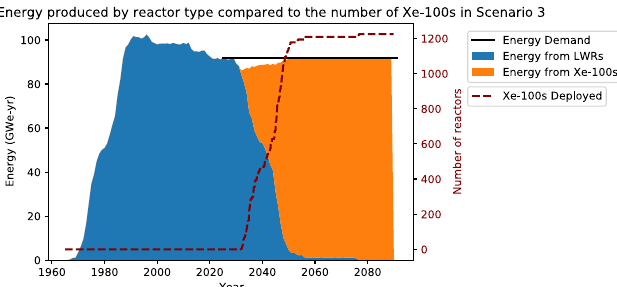
Fig. 8. Energy supplied by each type of reactor compared to the number of Xe-100s deployed in Scenario 3.